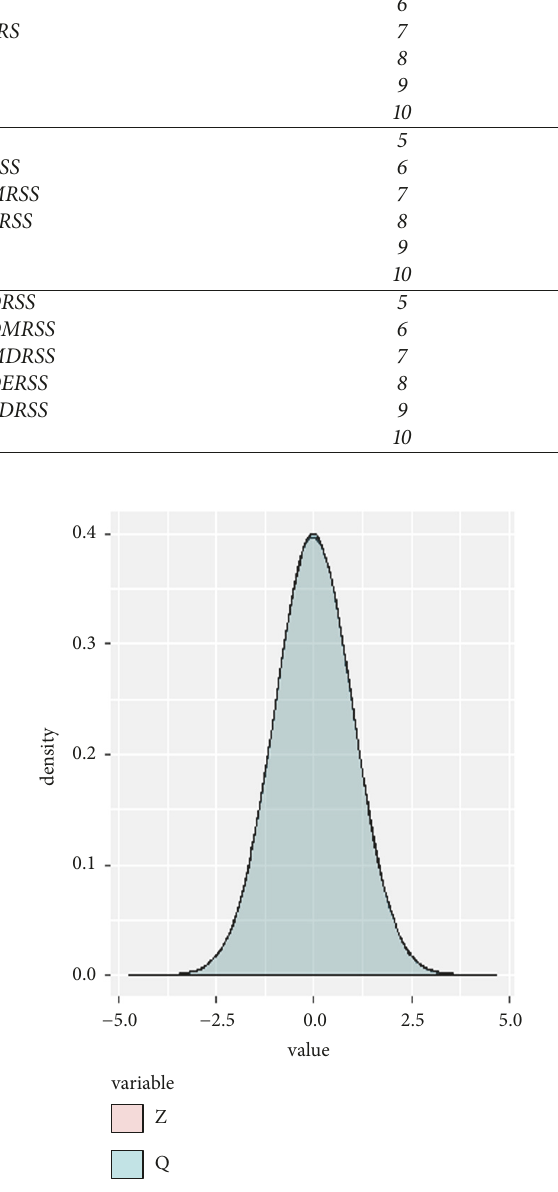
Figure 6: Kernel density plot of 𝑍 and 𝑄 at 𝑛 = 6 , 𝑇 = 𝐸𝑅𝑆𝑆 , and 𝜌 = 0.75 𝑋𝑌